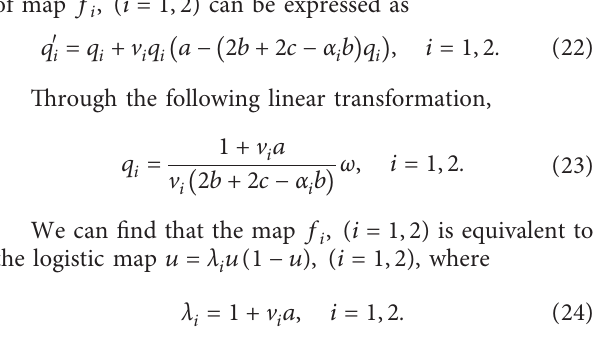
and α , where the rest parameters are fixed as follows: (a) a � 4 . 69976212, c � 0 . 36680549, 1 2 � 0 . 777; (b) a � 4 . 8208, c � 0 . 0425, b � 0 . 1322, v 2